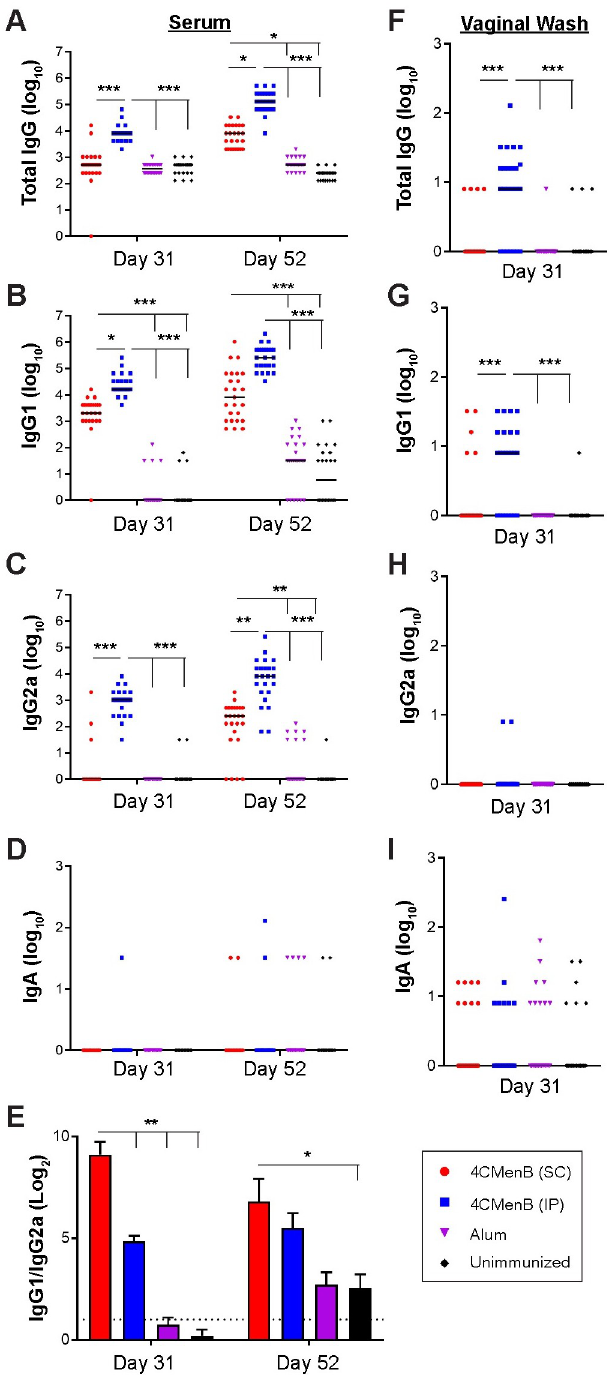
Fig 1. Serum and vaginal antibody titers against F62 OMVs from 4CMenB-immunized mice. Groups of 25 BALB/c mice were immunized three times, three weeks apart with 250 μ l or 4CMenB by the IP or SC routes or with PBS or Alum (IP route). Serum and vaginal antibody titers on day 31 and day 52 (ten days after the 2 nd and 3 rd immunization, respectively) against F62 OMVs were measured by ELISA. Shown are serum (A) total Ig, (B) IgG1, (C) IgG2a, (D) IgA and (E) IgG1/IgG2a ratios for on days 31 and 52 (left column). Vaginal (F) total Ig, (G) IgG1, (H) IgG2a and (I) IgA on day 31 are shown in the right column. No difference was found in any sample or Ig tested between control animals receiving PBS and those receiving alum only. � , p < 0.05; �� , p < 0.01; ��� , p < 0.0001. Results from the repeat experiment were similar.